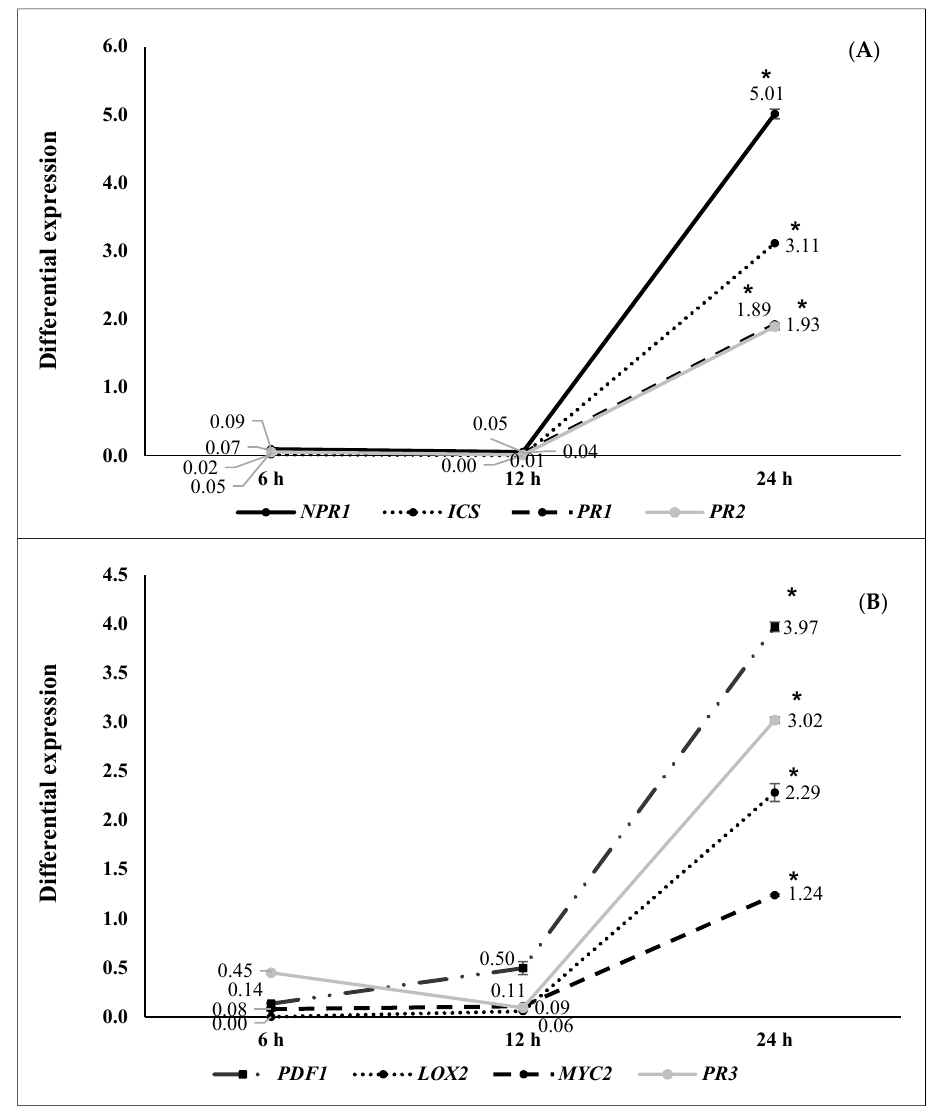
Figure 6. Differential gene expression (seedlings inoculated with N 4.1 ( Bacillus cereus ) vs negative control) at 6 ( n = 16), 12 ( n = 16) and 24 ( n = 16) hapc; ( A ) NPR1 , ICS , PR1, and PR2 genes (as SA signaling pathway markers) and ( B ) PDF1 , LOX2 , MYC2, and PR3 (as JA/ET signaling pathway markers). Asterisks represent statistically significant differences ( p < 0.05) with respect to negative control (differential expression of 1).